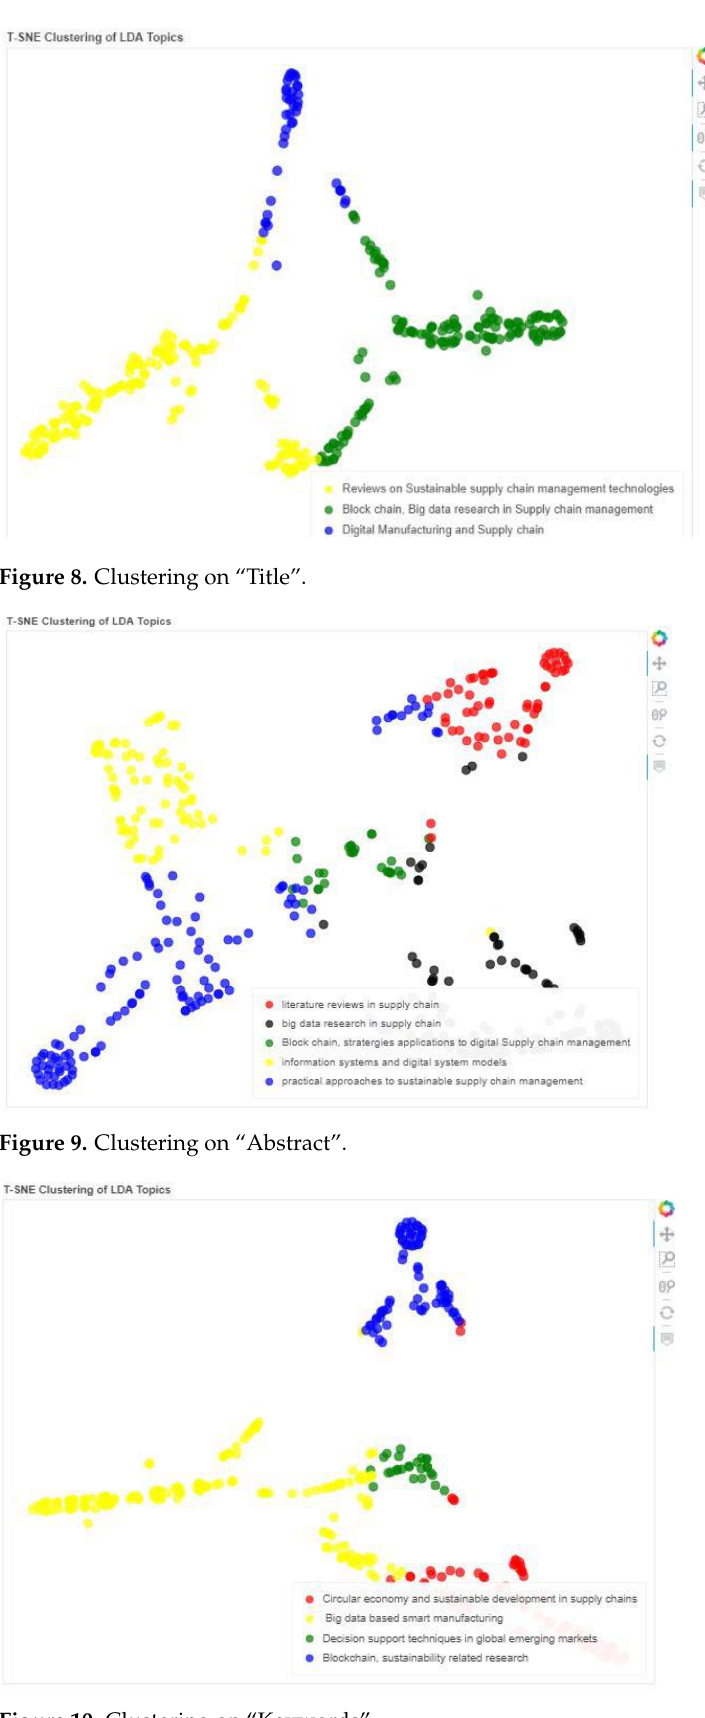
Figure 10. Clustering on “Keywords”.